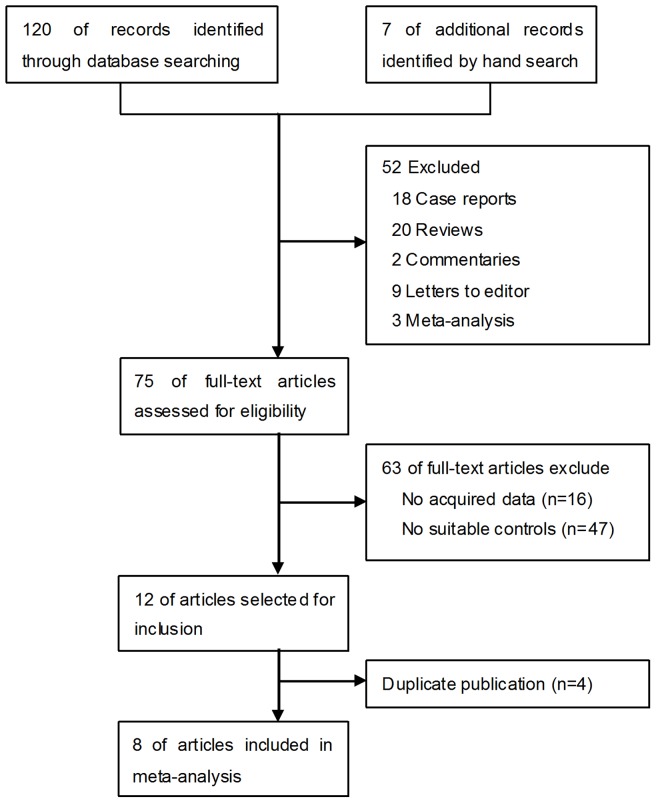
A flow chart showing the progress of trials through the review.